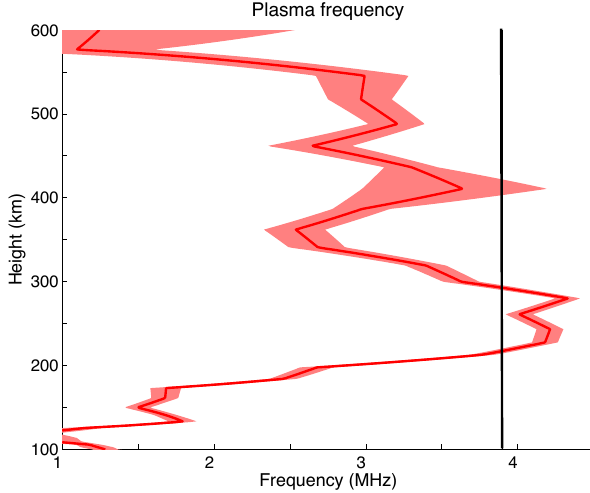
Figure 1. Height profile of f p with f 0 = 3 . 900MHz shown as a solid line (14:11:15UT and integrated for 10s on 12 Novem- ber 2015). The data were obtained with the EISCAT UHF radar from the ion line and the width of the profile shows the approxi- mate standard